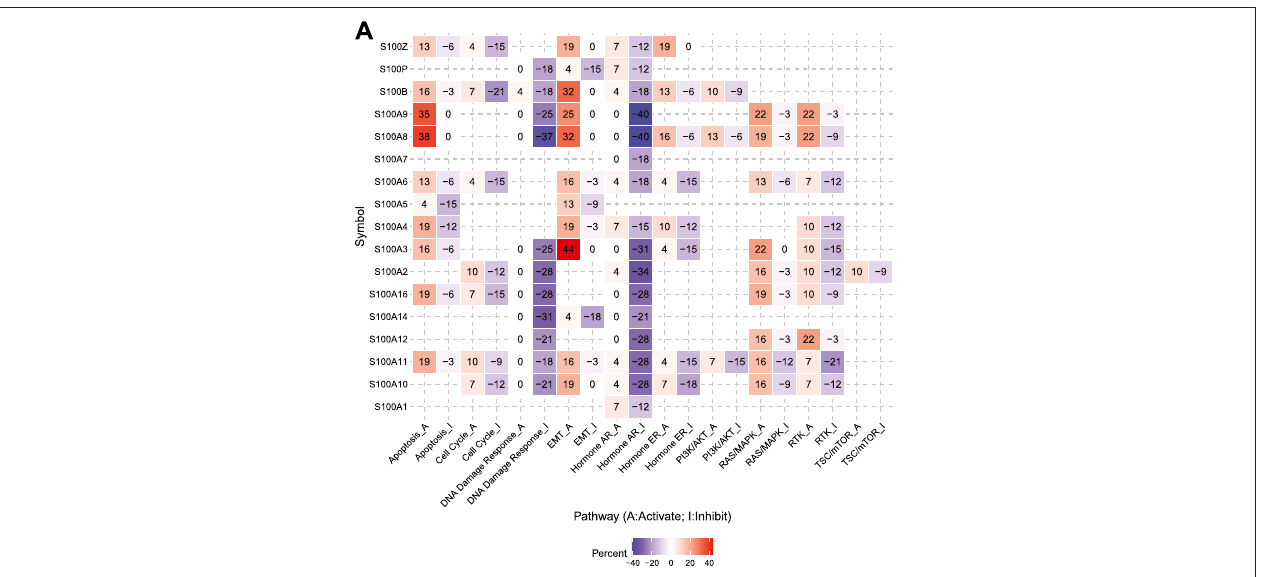
FIGURE 8| Cancer pathway activity and drug sensitivity analysis ofthe S100s in PAAD (GSCALite, n (cid:1) 178). (A) The role ofthe S100s in the famous cancer-related pathways. (B) SpearmancorrelationshowedthatS100geneexpressionwasrelatedtosmalldrugs.Negativecorrelationmeansthathighgeneexpressionissensitiveto the drug, and vice